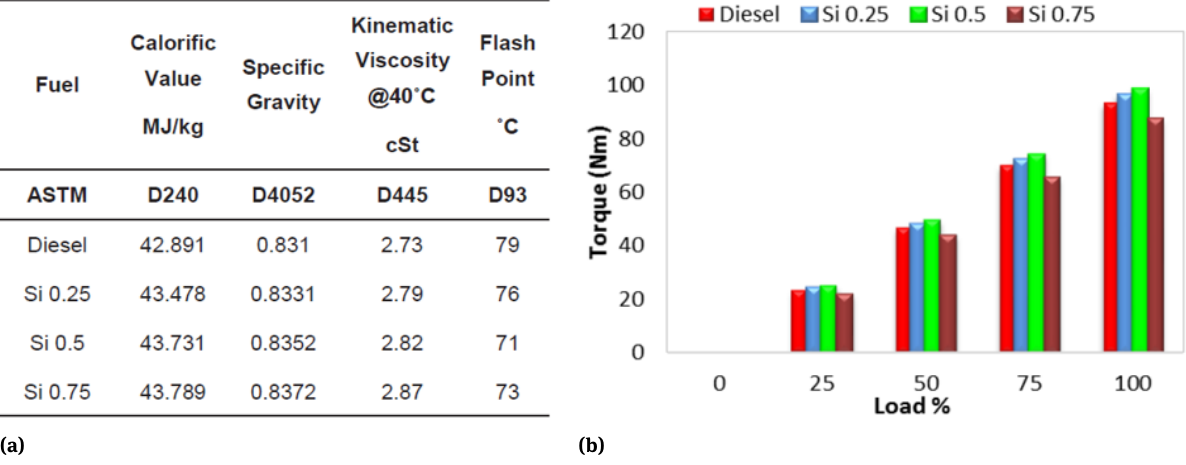
Figure 6: Physico-chemical properties of the tested fuels by authors in [38] and load carrying capacity of the